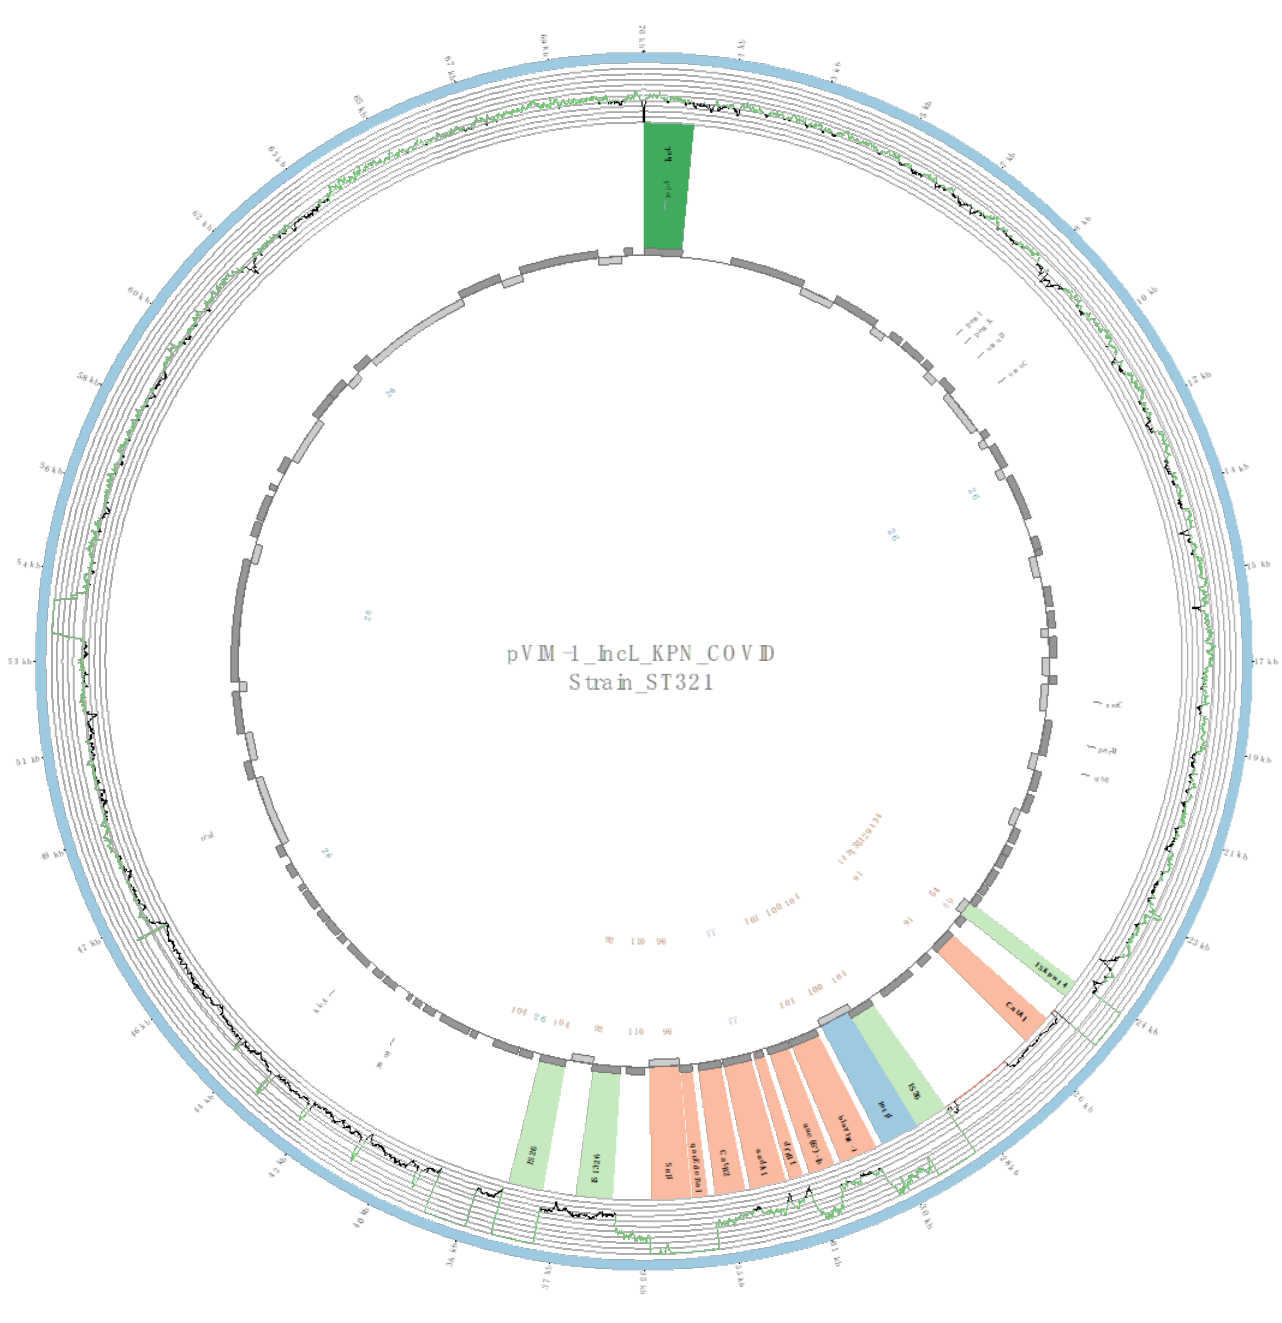
Figure 5. Overview of the IncL plasmid harboring bla VIM-1 detected in a strain of ST321: The figure represents the homology between the IncL plasmid and a highly similar plasmid identified in the GenBank database (blue outer ring). The graph represents the reads mapped against this reference sequence with a depth of coverage ranging from 0 (red) to 500, with orange indicating values of 1 to 20 reads and green indicating values higher than 200 reads. Gray boxes represent the coding sequence from automatic annotation, with dark and light colors being used when they were found on the forward or the reverse strand, respectively. Colored stripes represent a more detailed annotation that includes antibiotic resistance genes in red, insertion sequences (IS) in light green, integrases in blue, and Rep genes in dark green. The homology between the reference plasmid and the assembled contigs is represented in the inner ring, with each contig colored according to its number.